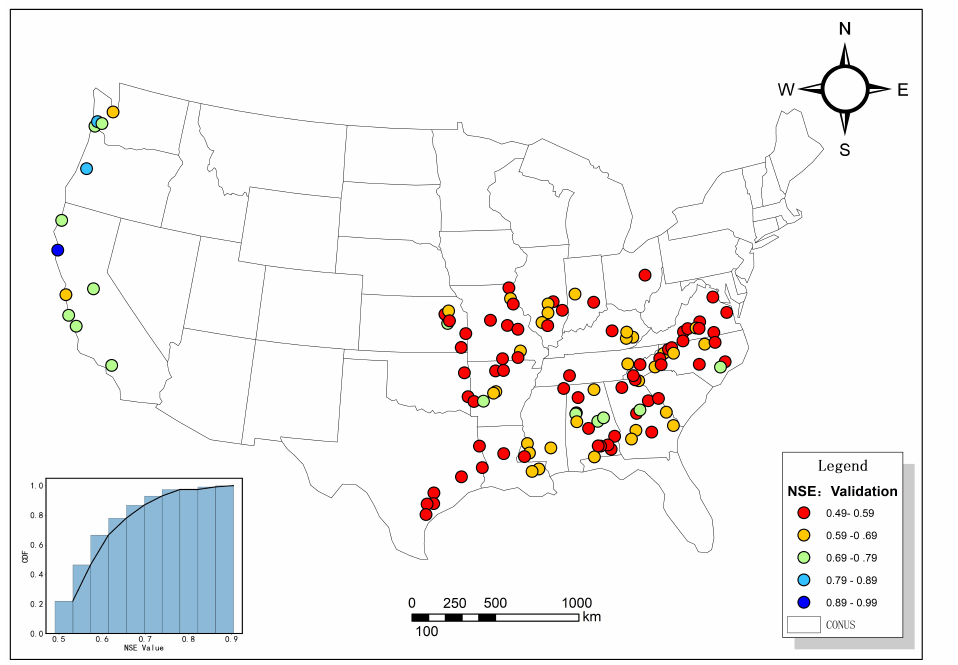
Figure 3. Nash–Sutcliffe model efficiency coefficient (NSE) of 196 catchments in CAMELS data set averaged over validation